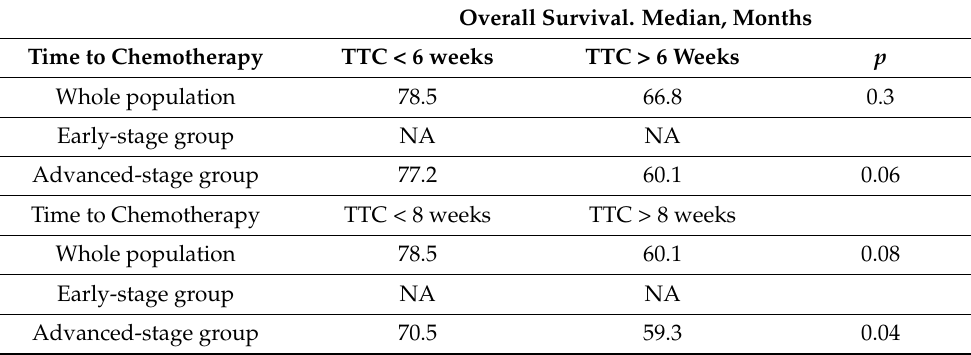
Table 3. Overall Survival according to the TTC the whole population and Early- and Advanced-stage groups, when Time to Chemotherapy occurs before and after 6 and 8